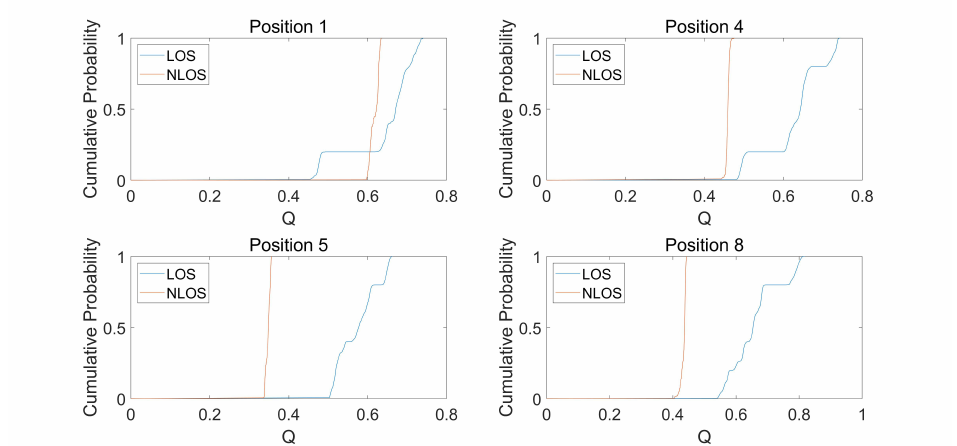
Figure 12. CDF of Q of every position in the positioning